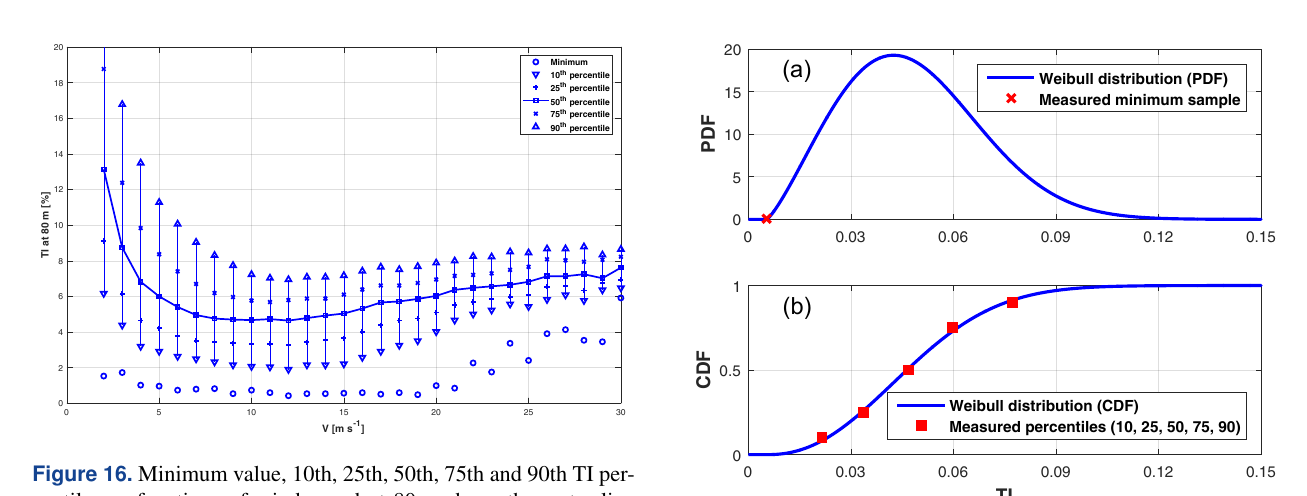
Figure 15. Mean estimation error of yaw misalignment (a) , vertical shear (b) , upflow angle (c) and horizontal shear (d) with respect to wind speed.